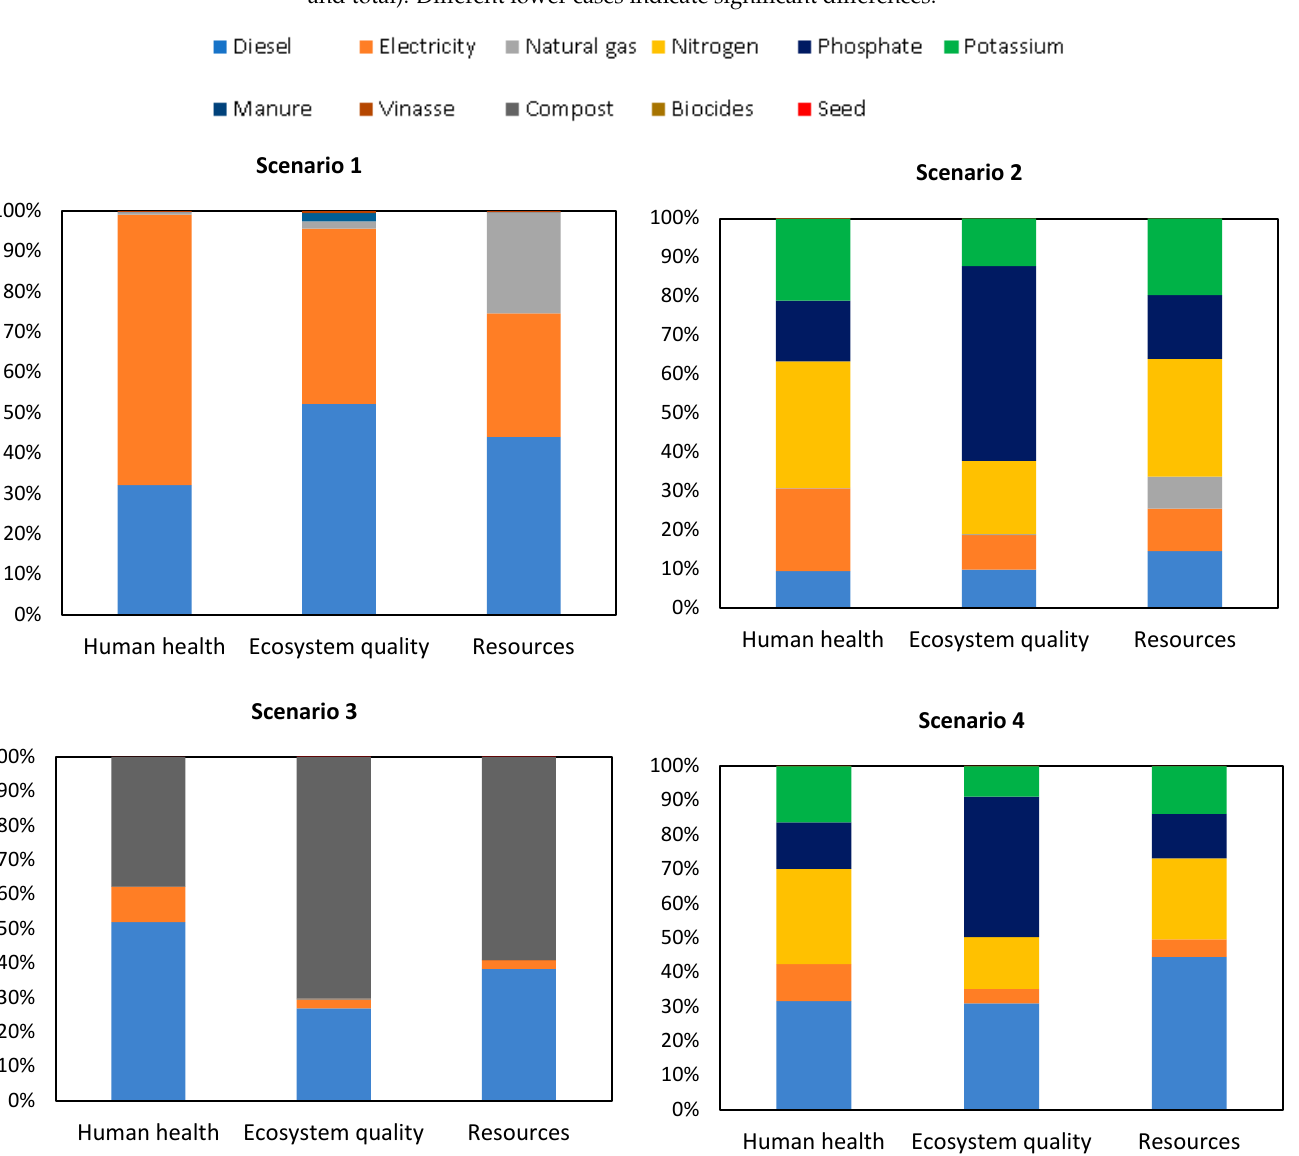
Figure 4. Contribution of inputs to the environmental impact categories in different scenarios (Scenario 1: Greenhouse—Organic, Scenario 2: Greenhouse—Conventional, Scenario 3: Open Field— Organic, Scenario 4: Open Field—Conventional).